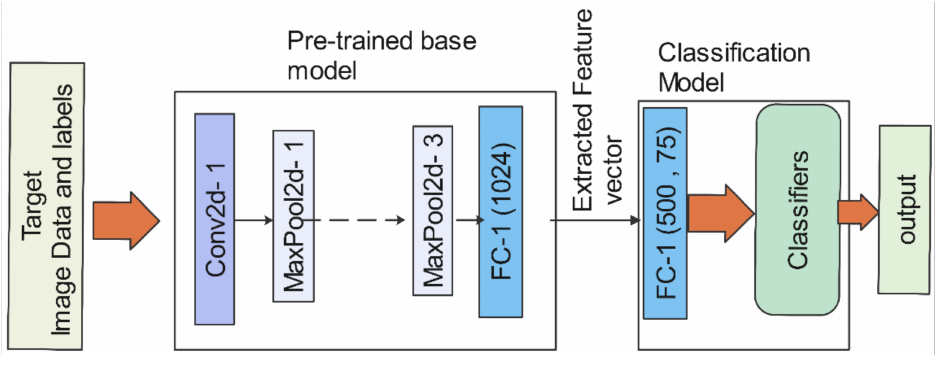
Figure 4. Feature extraction from the pre-trained model-based feature extractors and classification model.